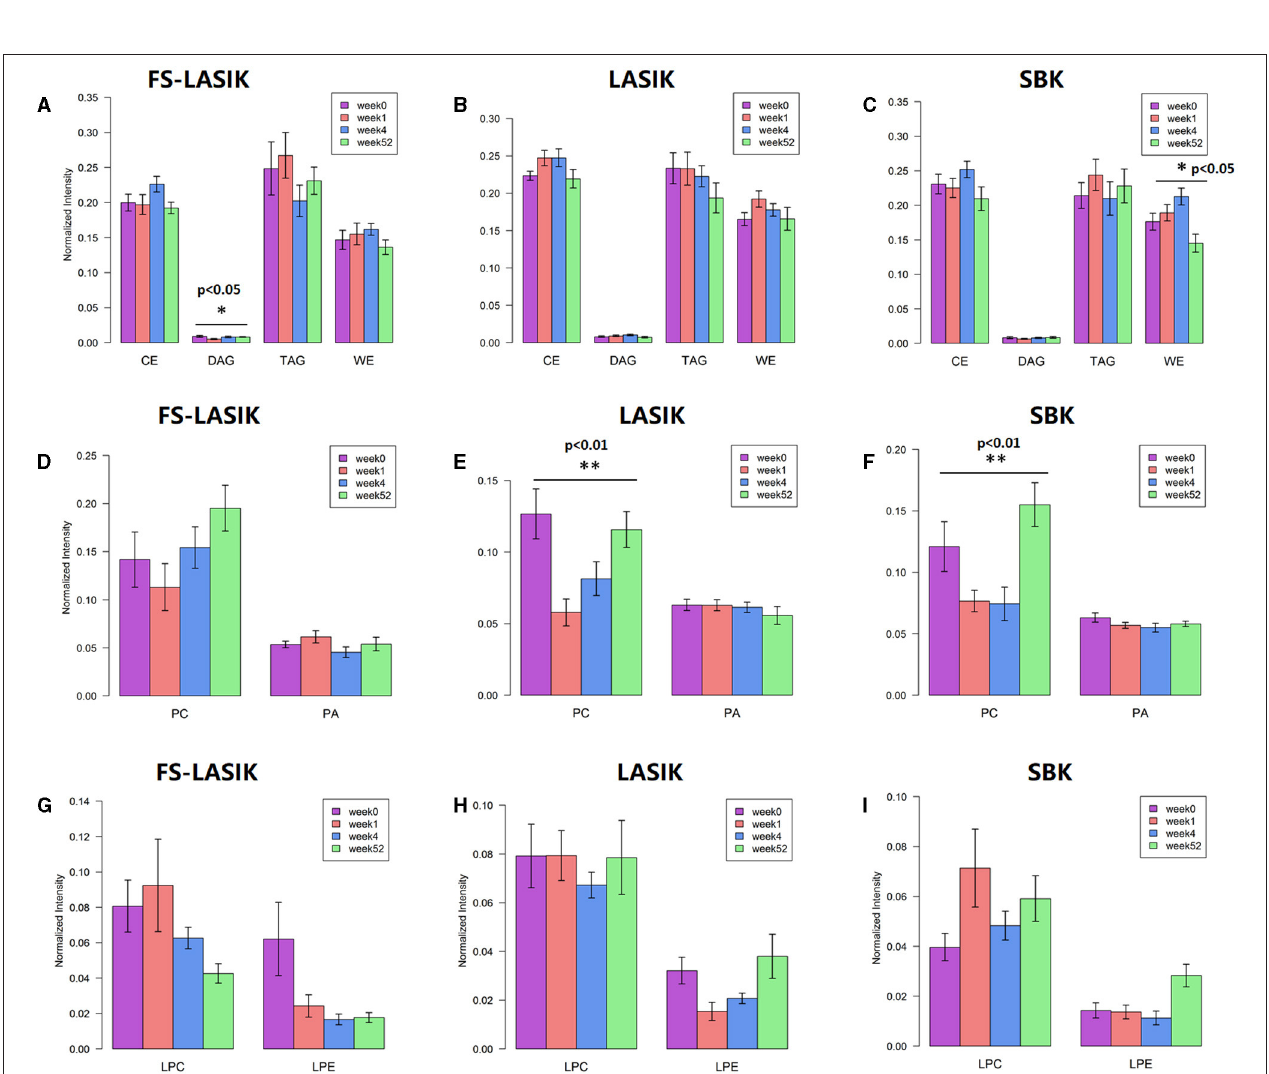
Frontiers in Medicine |